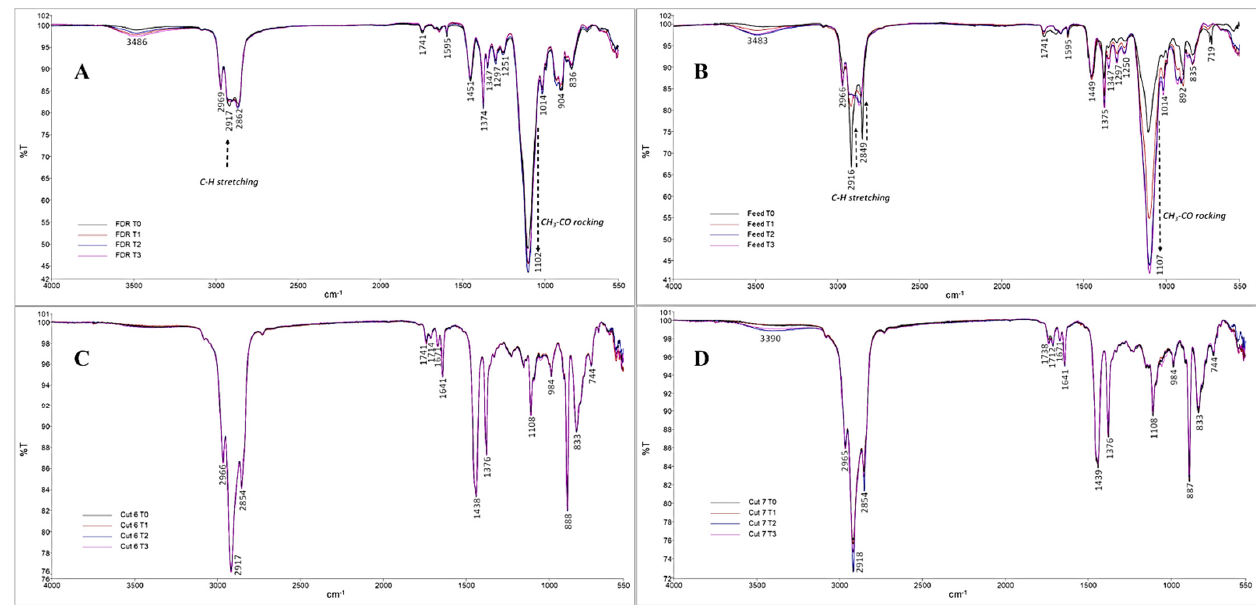
Figure 1. Overlay of the Fourier transform infrared spectroscopy (FTIR) spectra of FDR ( A ), Feed ( B ), C6 ( C ), and C7 ( D ) samples throughout the stability test (T0, T1, T2, and T3).